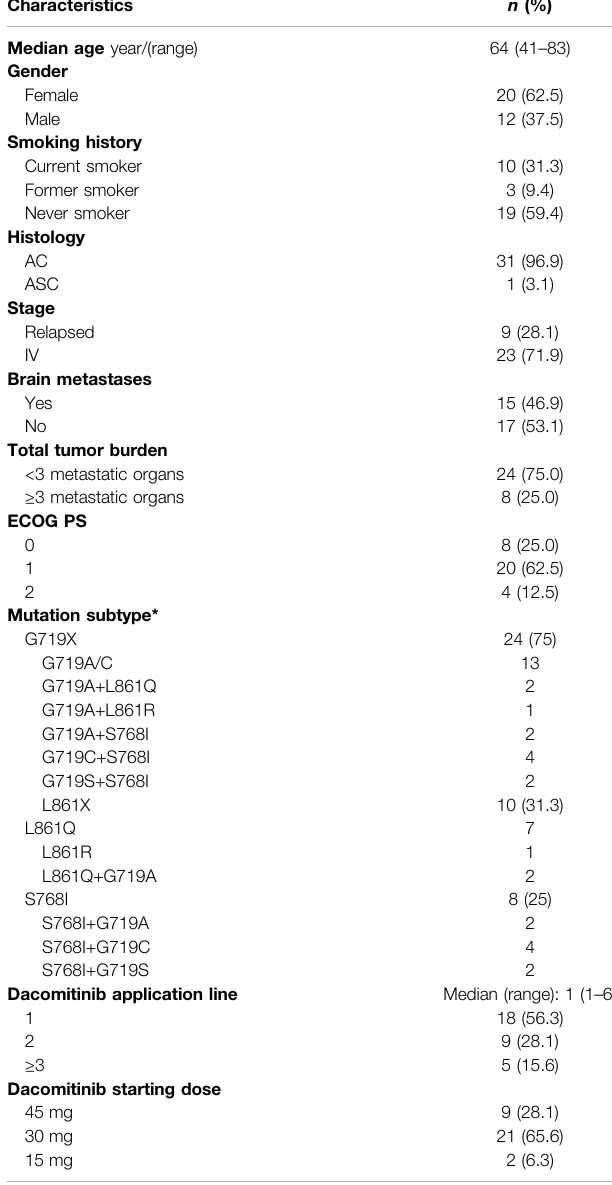
TABLE 1 | Baseline characteristics (N =